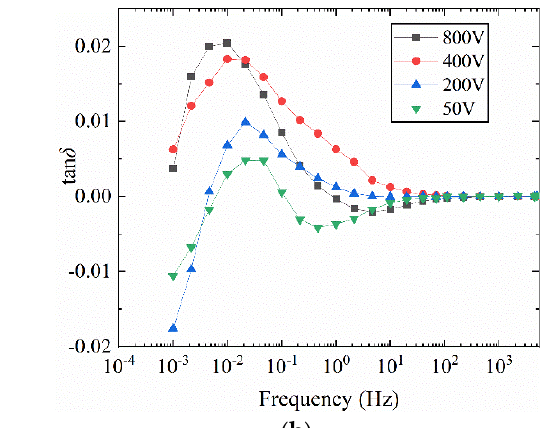
Figure 13. Influence of different wiring methods on tan δ - f curve of bushing model at different voltages (30 °C). It can be obtained from Figure 12 that the tan δ - f curve at 40 °C has a similar law with the curve in Figure 10. But as the temperature decreases, the frequency of loss peaks also decreases. Similarly, the difference between the two sets of curves under the same voltage in Figure 12(a) is obtained as Figure 12(b). The main peak frequency of the loss peak in Figure 12(b) gradually decreases with increasing voltage, and the variation range is between 0.01 Hz and 0.03 Hz. When the test temperature is further reduced to 30 °C, the tan δ - f curve in Figure 13 only shows a significant difference when the frequency is less than 0.1 Hz. As the test temperature decreases, the frequency band of the curve difference decreases. The difference is that when test temperature is 30 °C, no obvious main peak of the loss peak can be observed in the tan δ - f curve. Compare the tan δ - f curves of 800V voltage at three different temperatures, as shown in Figure 14. When the test temperature is 50 °C, the tan δ - f curve of the two connection methods shows obvious